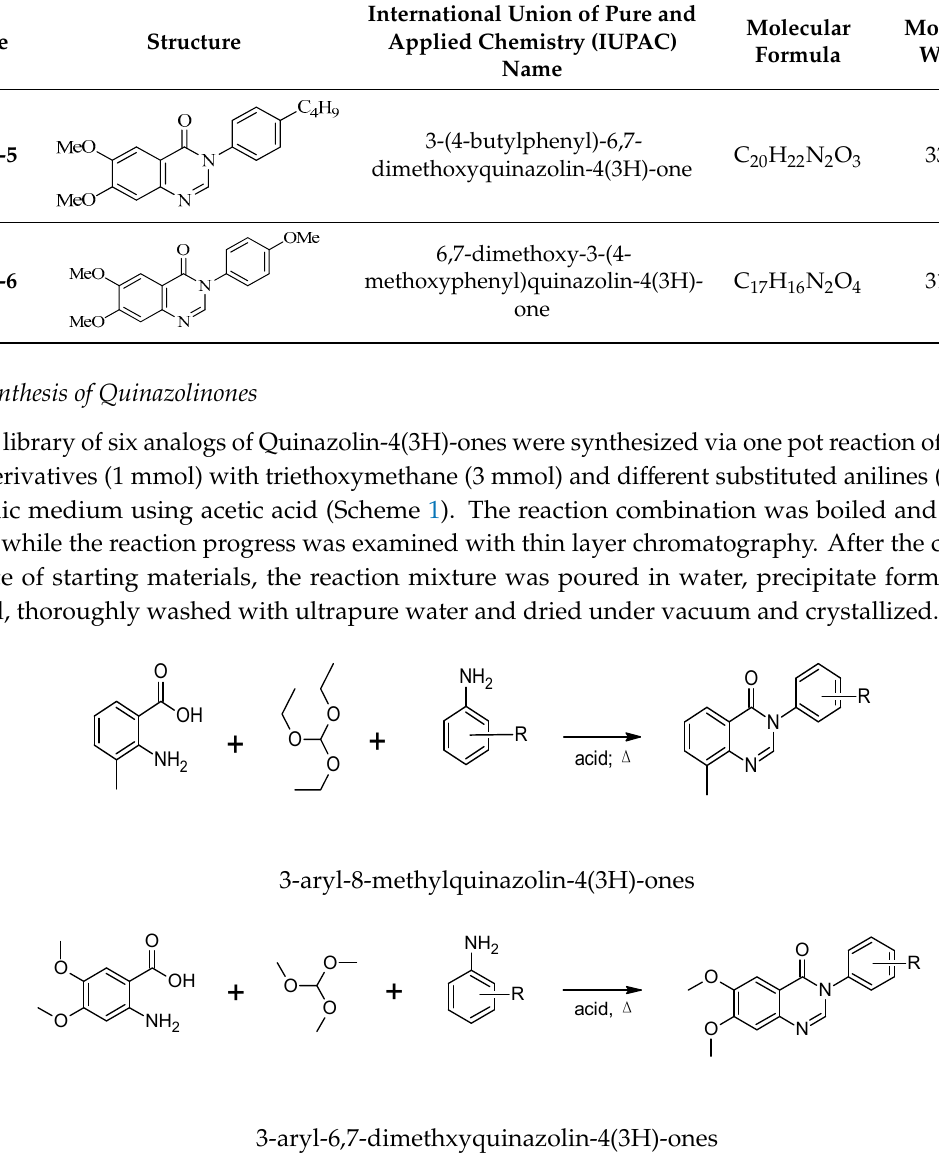
Scheme 1. The chemical synthesis of six quinazolinone derivatives.